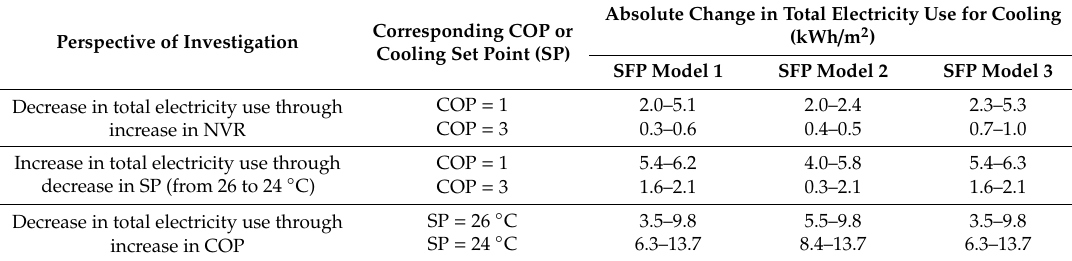
Table 11. The ranges of decrease or increase in total electricity use for cooling (kWh / m 2 ) during summer season through di ff erent perspectives of investigation in the three defined SFP models.